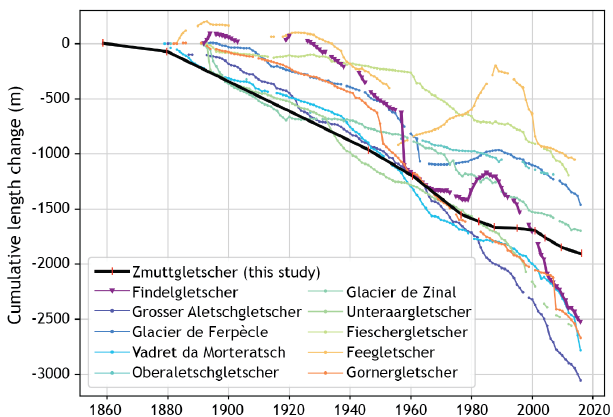
Figure 6. Current extent of debris cover and its evolution since 1859 ( ∼ the end of the LIA) together with the glacier outlines for LIA and 2016. Even though the glacier has retreated in the debris-covered region, debris covers more and more of the total glacier